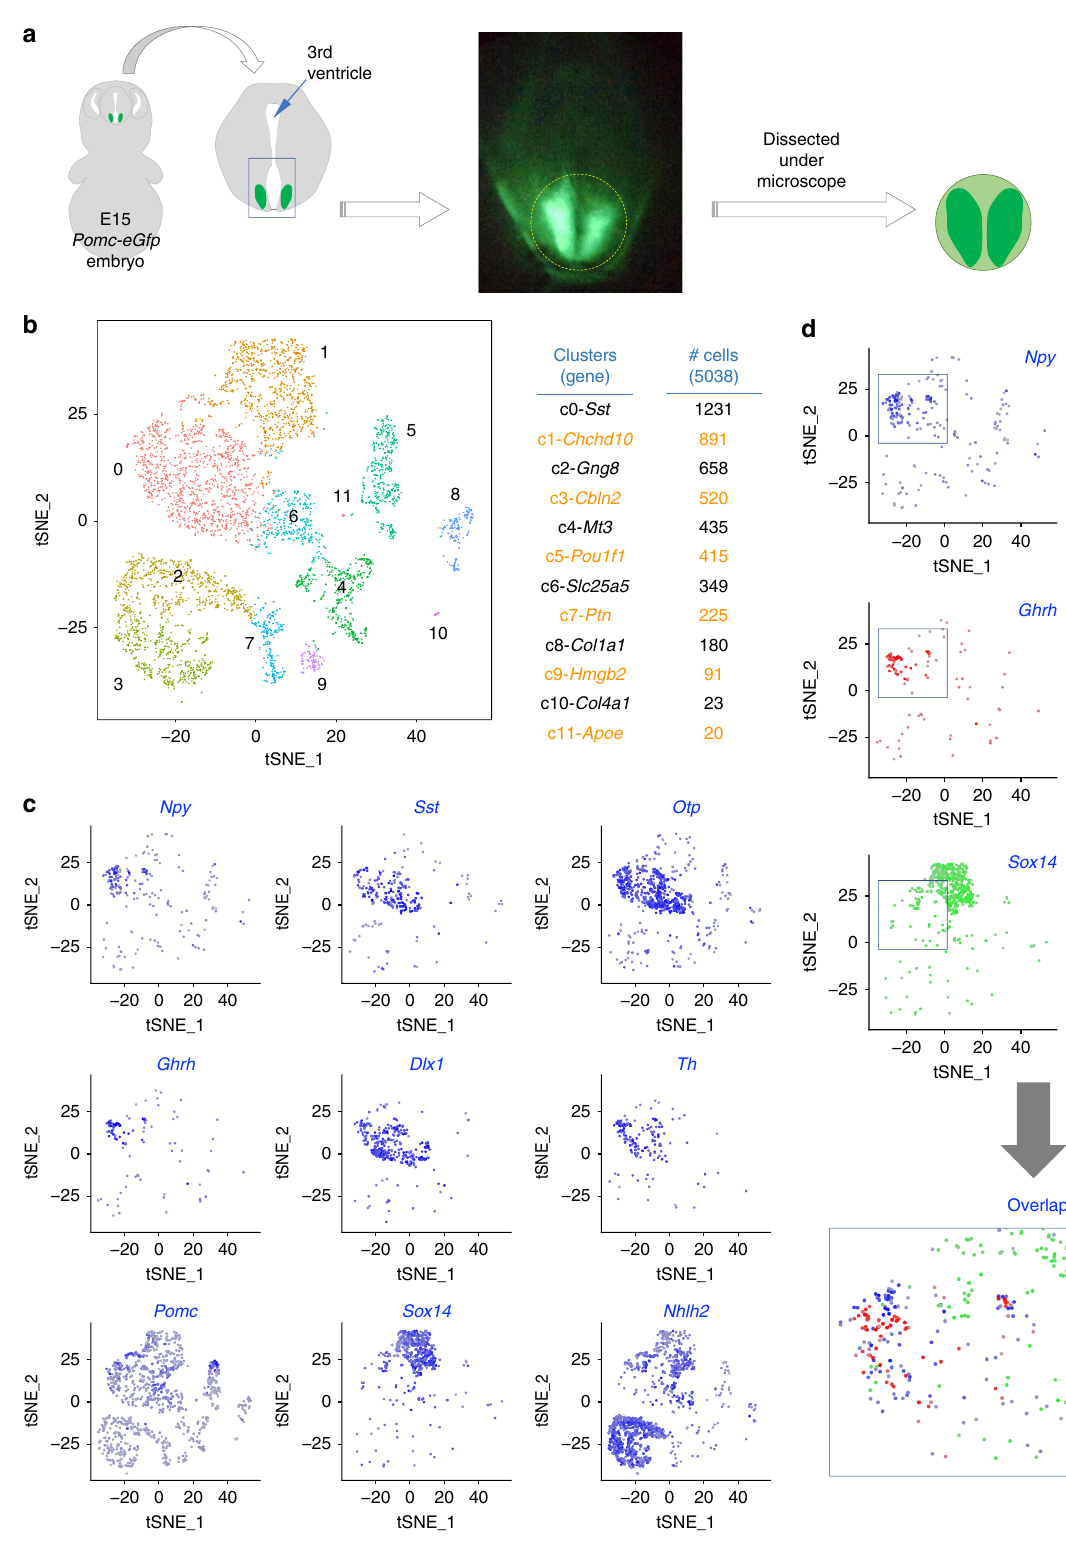
Fig. 1 scRNA analysis of E15 ARC. a Schematics for dissecting out the developing ARC region from E15 Pomc-eGfp embryos. b Spectral tSNE plot of 5038 cells from E15 ARC, colored according to gene expression, reveal 12 clusters of cells (the clusters c0 to c11). The number of cells (#) in each cluster and the most speci fi c gene in each cluster are as shown. c Spectral tSNE plot of 5038 cells from E15 ARC, colored for the expression of representative key marker genes of ARC neurons, Npy/Sst/Otp for Agrp Sst -neurons, Ghrh/Dlx1 for Ghrh-neurons, Dlx1/Th for Th-neurons, Pomc/Nhlh2 for POMC-neurons, and Sox14/ Nhlh2 for Kisspeptin-neurons. d Overlap of three spectral tSNE plots of 5038 cells from E15 ARC, colored differently for Npy (blue), Ghrh (red) and Sox14 (green), reveals that their expressions in the cluster c0 are mutually exclusive, suggesting that the cluster c0 likely represents a pool of multiple